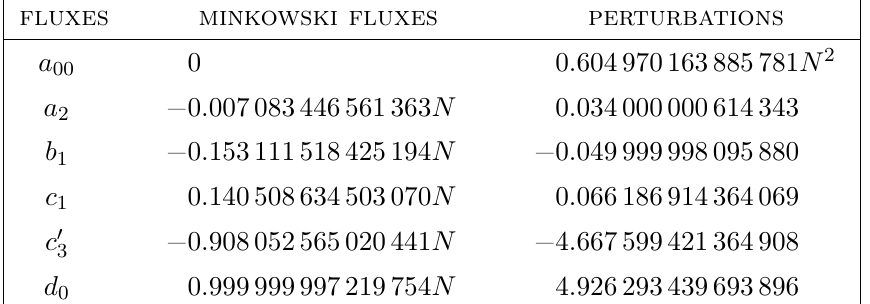
Table 7 . Choice of (cid:13)uxes corresponding to a stable de Sitter minimum. Fluxes for the Minkowski vacuum from table 3 are scaled with N and perturbed with order 1 numbers. In addition, a constant term a 0 , proportional to N 2 is added to the